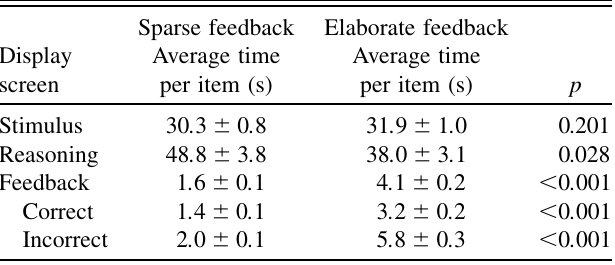
TABLE III. Average time spent (in seconds) viewing each screen: reading the problem pair and making a decision (stimu- lus), typing in an explanation in the reasoning prompt screen, and viewing the feedback display screen. Participants in both groups spent slightly more time viewing the feedback screen when they answered an item